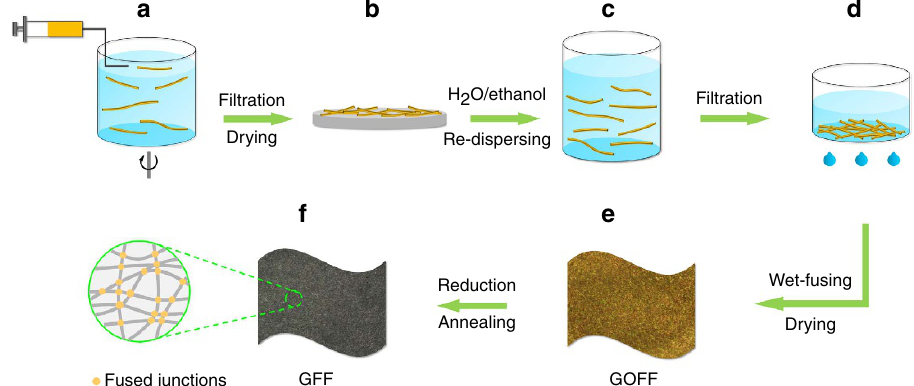
Figure 1 | Fabrication of GFFs via wet-fusing assembly. ( a ) Continuous wet-spinning of GO staple fibres. ( b ) First drying of the as-spun GO fibres. ( c ) Re-dispersion of dried GO fibres in the mixture of H 2 O and ethanol. ( d ) Wet-fusing assembly of GO fibres after filtration of the re-dispersed fibres. ( e ) A free-standing GOFF with brownish colour after drying. ( f ) A grey GFF after chemical reduction or thermal annealing with randomly oriented and interfused graphene